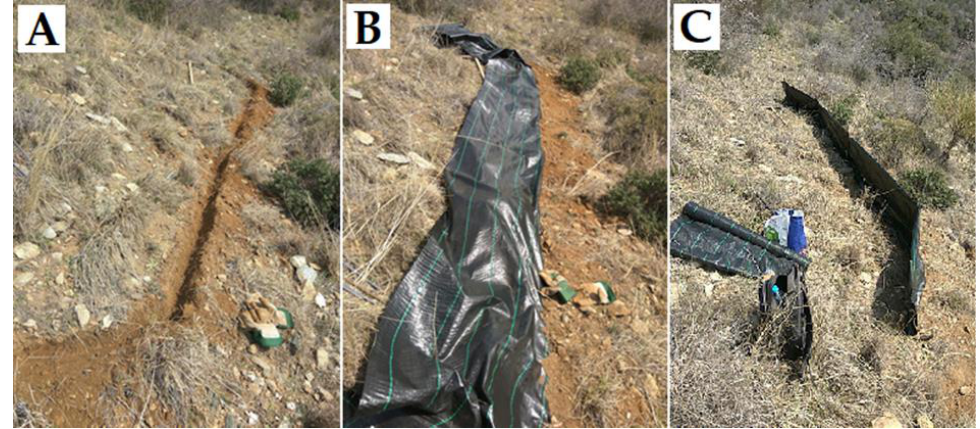
Figure 4. Silt fence during the installation process: ( A ) hand-dug ditch to insert the geotextile; ( B ) the geotextile compacted with ground in the ditch; ( C ) the silt fence was fastened on 5 metal rebars. The field plots were monitored from December 2020 to January 2022, in which 17 field measurements were organized to collect the sediments from the silt fences. After each intense rainfall or once in a month (in case there was no intense rain), field work was carried out to collect the sediments retained by the silt fences. The weighing was implemented on site using a scale of 2 decimal places. A sample of soil material was collected from each silt fence every time and was later dried in the laboratory chamber at 105 °C for 24 h to calculate the soil water content and the dry weight of the eroded soil [52]. The sediments collected from each surface were summed and divided by the area of the field plot (110 m 2 ) to obtain the annual erosion rate.